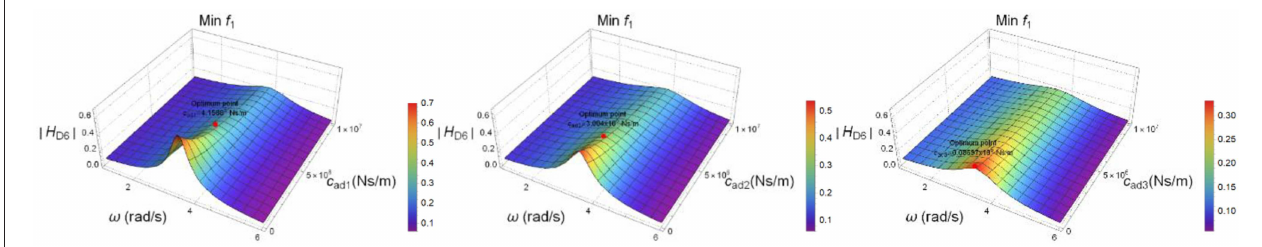
H D 6 based on f 1 minimization with respect to excitation frequency and added damping parameters. (cid:12) (cid:12) (cid:12) (cid:12)